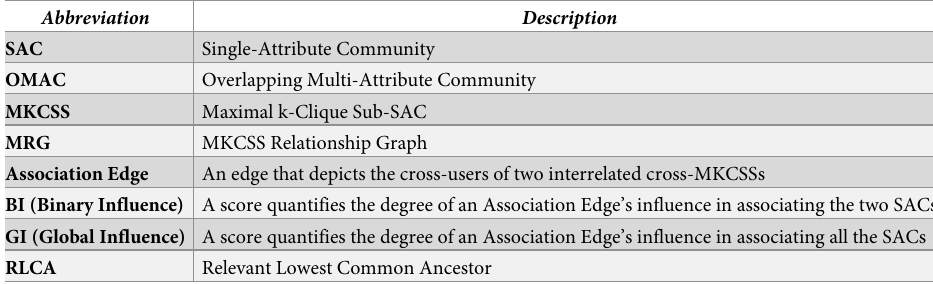
Table 1. Abbreviations of the concepts presented in the